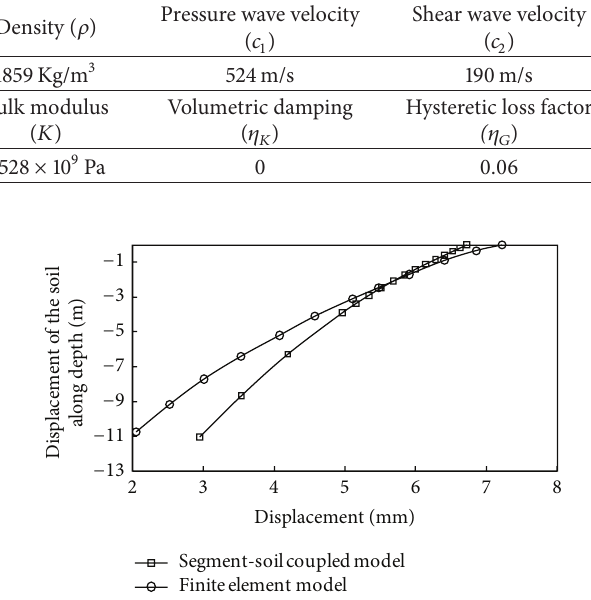
Figure 11: Settlement along the depth of the